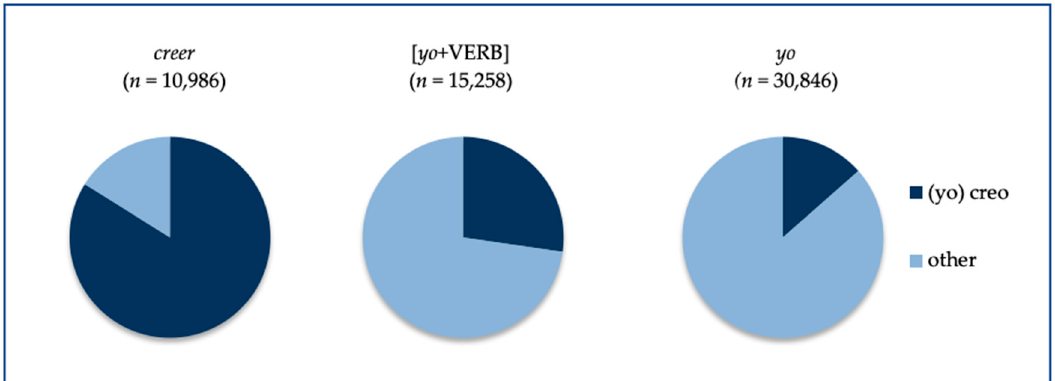
Figure 7. Relative proportion of data represented by (yo) creo in the oral portion of the Corpus del Español (Genre-Historical Corpus, Davies 2002). The relative frequency of (yo) creo with respect to its component parts is high: 88% of creer , 27% of [ yo + VERB ], and 14% of yo.